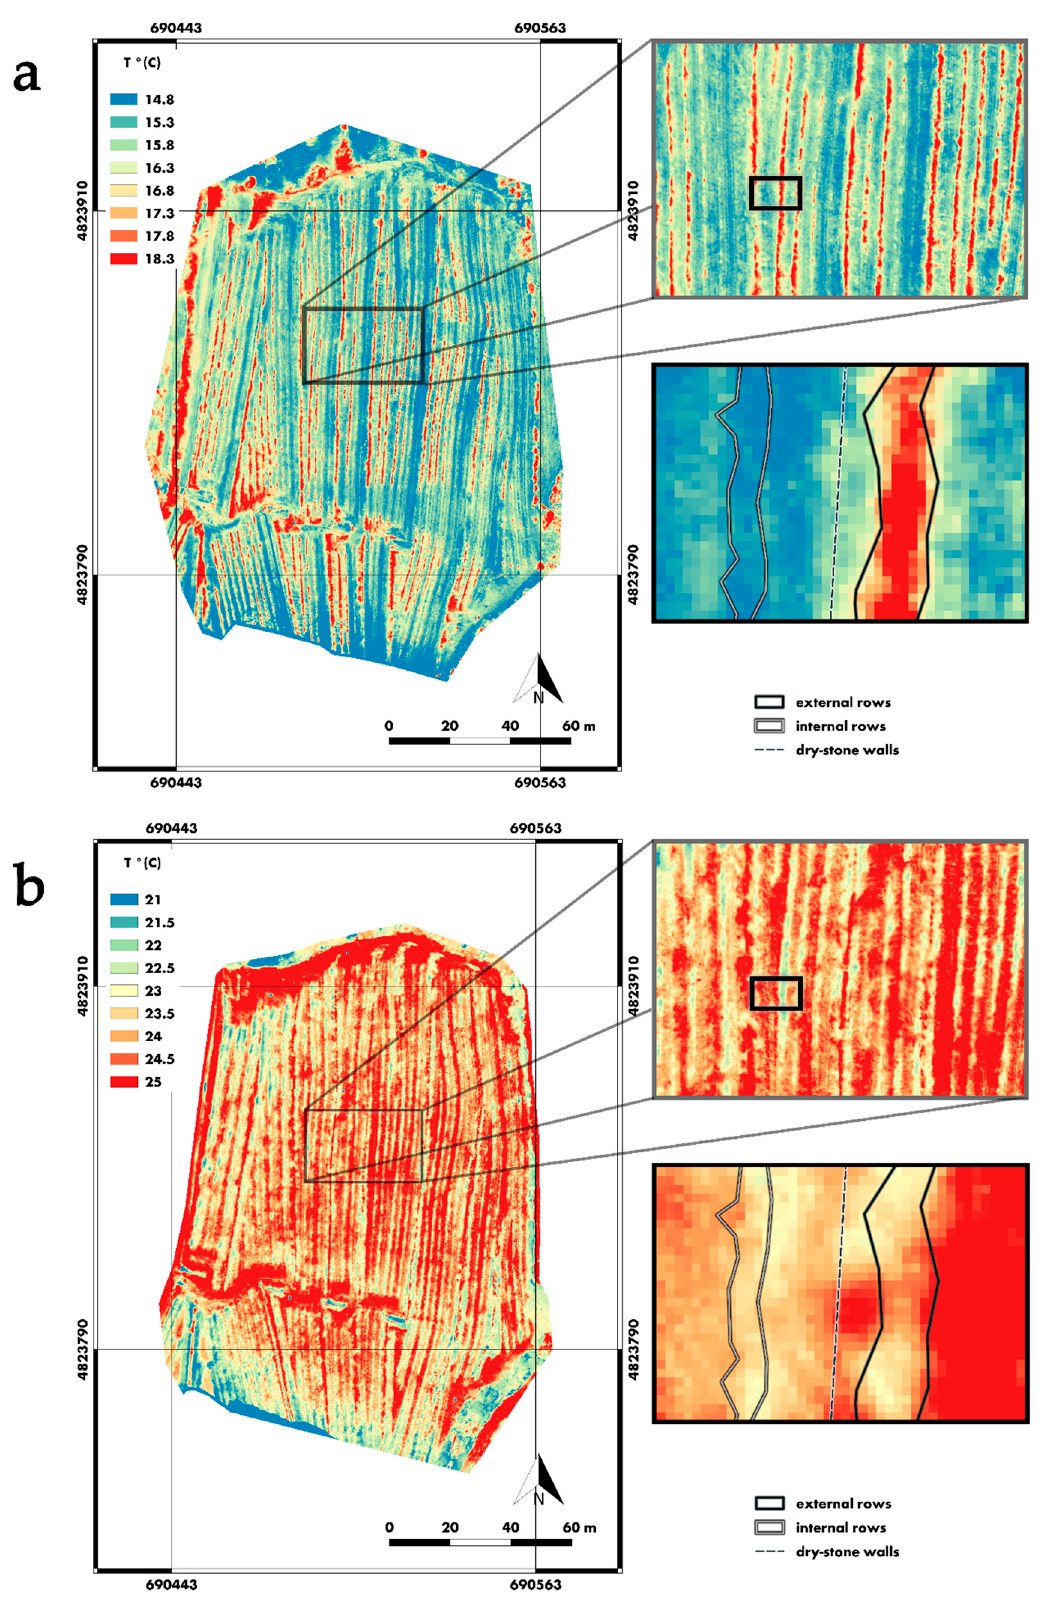
Figure 5. Thermal maps of the Grospoli vineyard in ( a ) morning (08.50 CET) and ( b ) afternoon (15:00 CET). The enlarged windows highlight internal and external rows, showing their respective thermal behaviours.